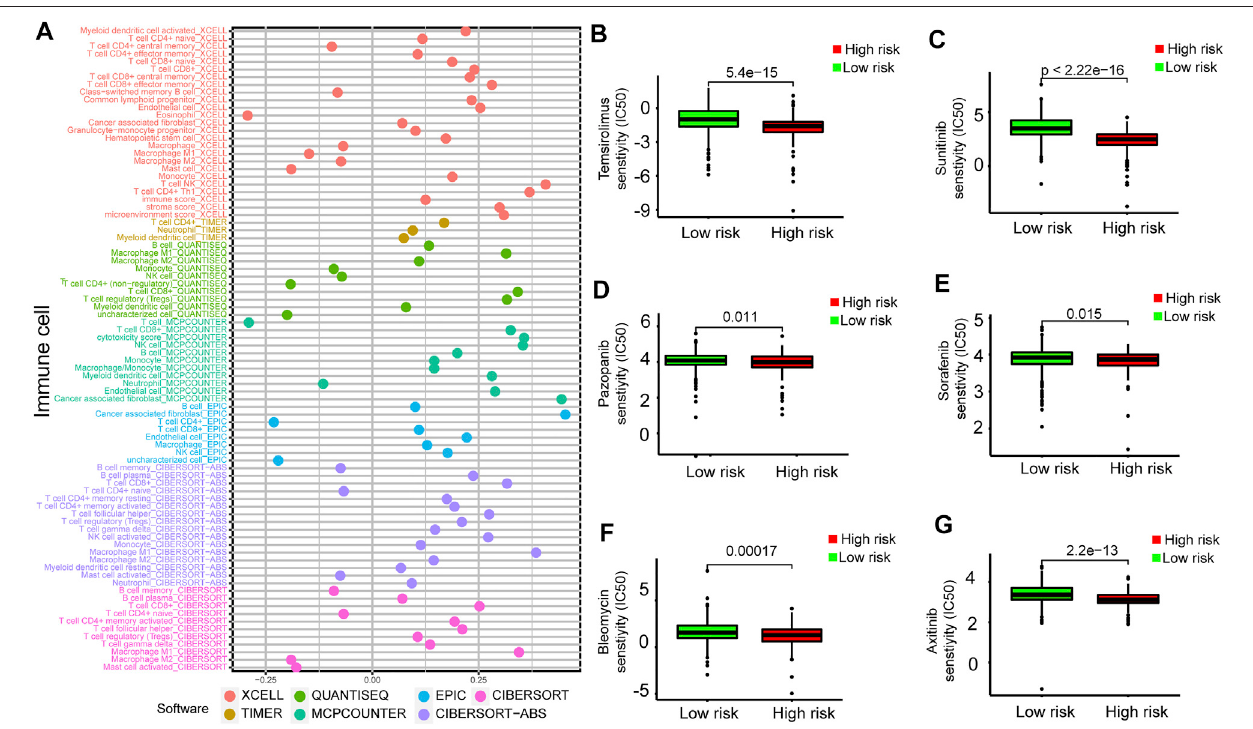
FIGURE 9| Estimation oftumor-in fi ltratingcells and drug susceptibility bythe prognostic model. (A) Spearman correlationanalysisbetween riskscore and tumor- in fi ltrating immune cells. (B – G) The model had the potential to predict chemosensitivity because a high risk score was associated with a lower half-maximal inhibitory concentration (IC50) of chemotherapeutics such as temsirolimus ( p = 5.4e − 15), sunitinib ( p < 2.22e-16), pazopanib ( p = 0.011), sorafenib ( p = 0.015), bleomycin ( p = 0.00017), and axitinib ( p = 2.2e − 13).